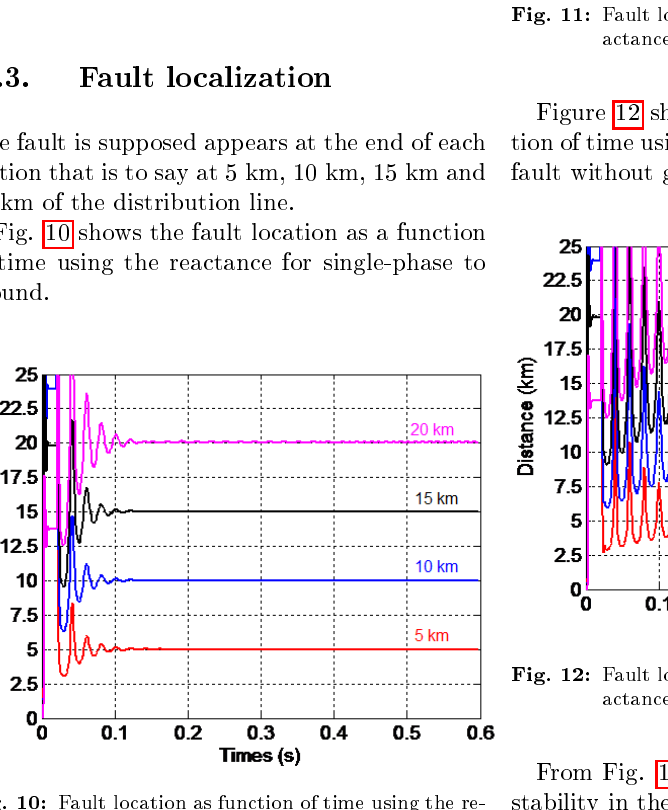
Fig. 10: Fault location as function of time using the re- actance for single-phase to ground.